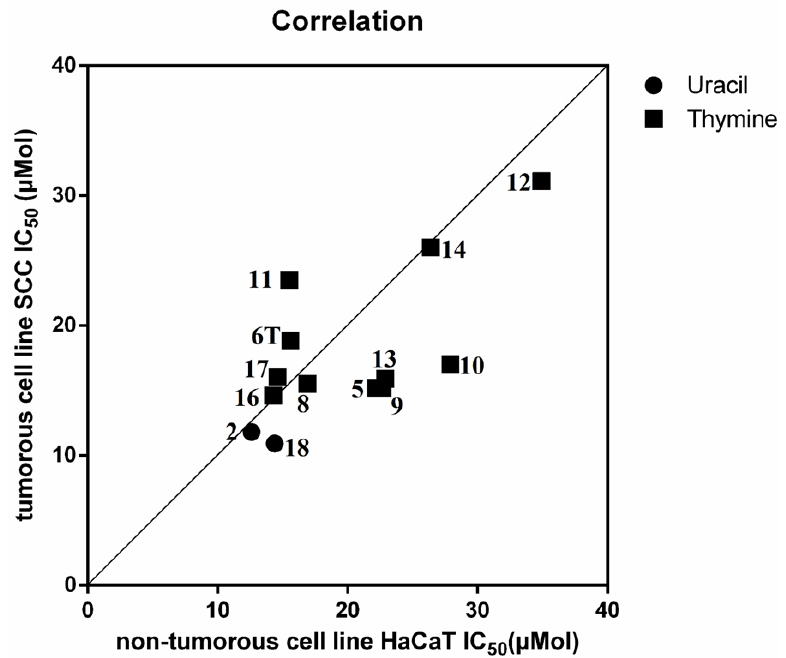
Figure 3. Correlation diagram indicating selectivity: IC 50 values for SCC cells are plotted against IC 50 values for HaCaT cells.